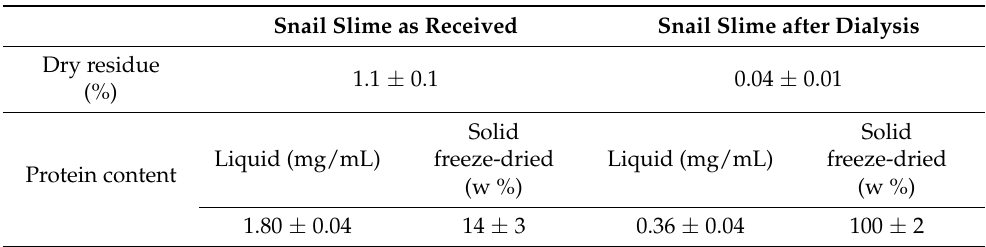
Table 1. Characterization of snail slime as received and after dialysis: evaluation of the dry residue and protein content. Each value is the mean of 5 tests and is reported with its standard